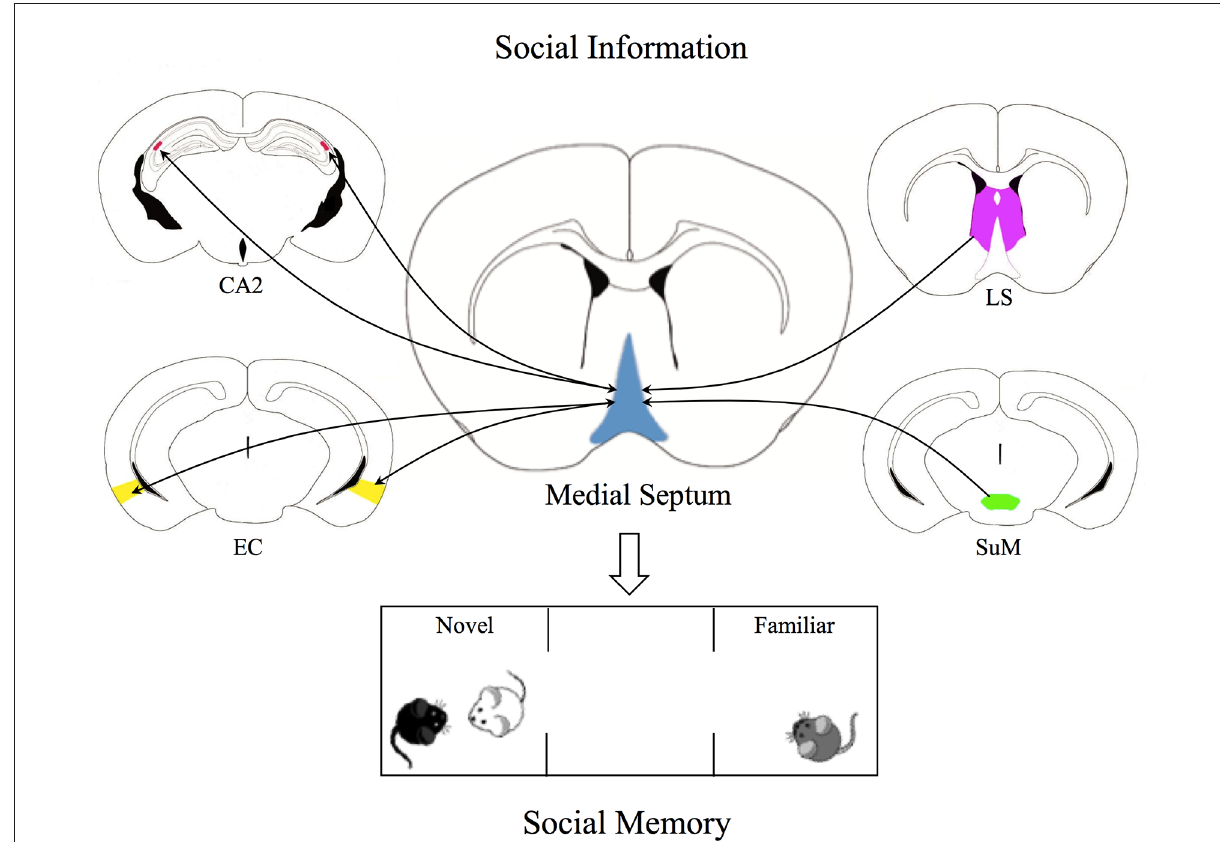
FIGURE1 The Medial Septum as a social recognition hub. Graphical representation of the Medial Septum (MS) as an integration center of social inputs from supramammillarynucleus(SuM)ofthehypothalamus,lateralseptum(LS),andentorhinalcortex(EC).SuMneuronssendglutamatergicprojections to parvalbumin-positive GABAergic interneurons and cholinergic neurons in the MS, contributing to regulation of MS-CA2 axis, crucial for social memory. GABAergic and cholinergic neurons in the MS receive inhibitory projections from the LS which in turn receives excitatory inputs from CA2, thus these projections indirectly inhibit MS neurons activity. In addition, glutamatergic and GABAergic projections from medial EC establish synaptic contacts with MS neurons, while MS neurons project to the medial and lateral portions of the EC. These bidirectional connections may be crucial for the integration of sensory inputs relevant for social recognition. All these pieces of evidence shed light on the complexity of the role of MS as a social hub able to integrate social information and to regulate social